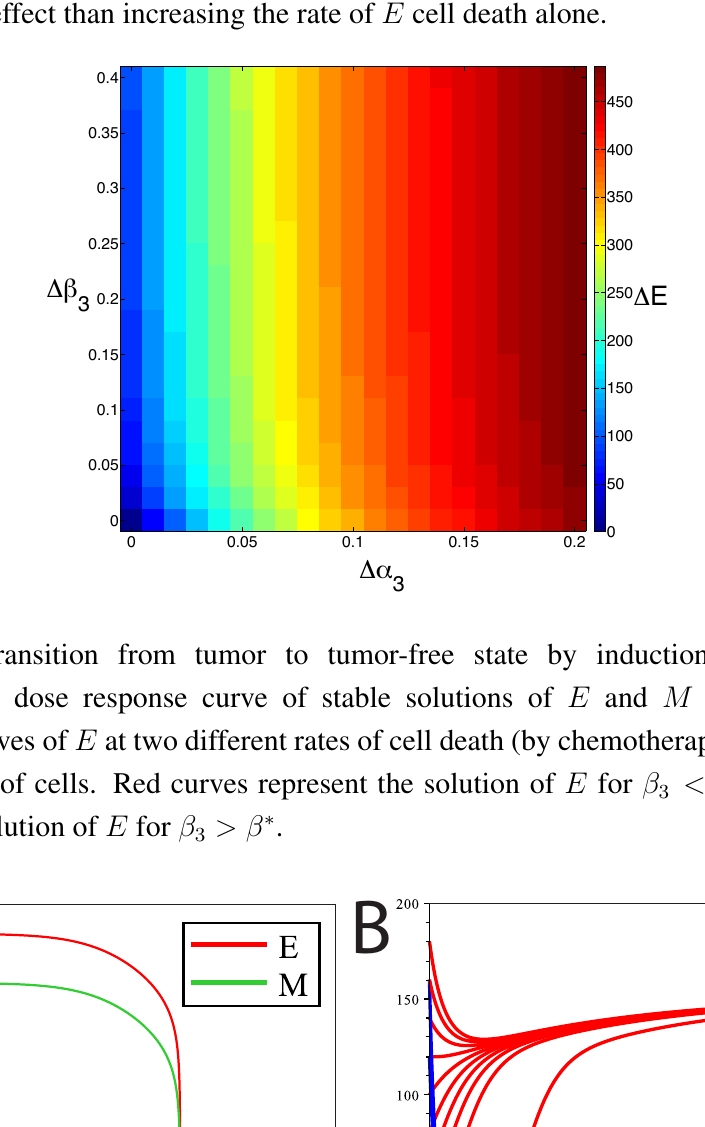
Figure 4. Model sensitivity to changes in cell death. We study the effect of increasing the cell death rate of M ( α ) and E ( β ) simultaneously. The output is colored by the extent to 3 3 which the steady state for E is shifted ( ∆ E ). Increasing the rate of M cell death has a much more dramatic effect than increasing the rate of E cell death alone.